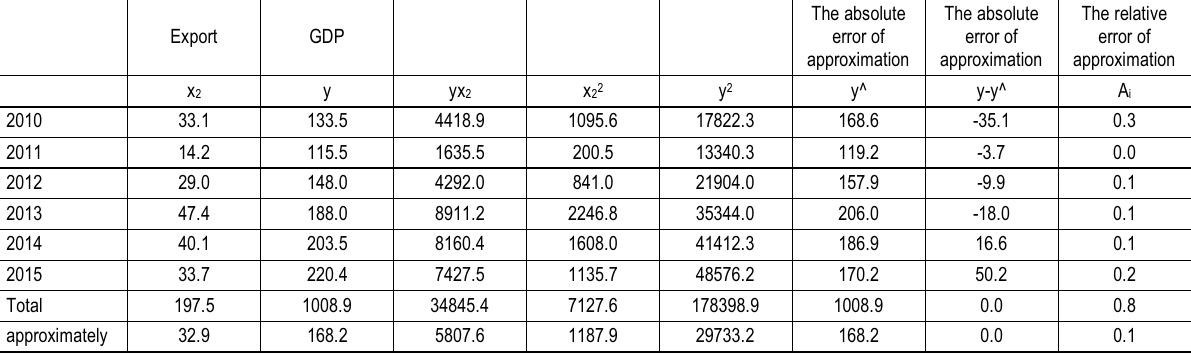
Table 4. Initial data for the regression analysis of